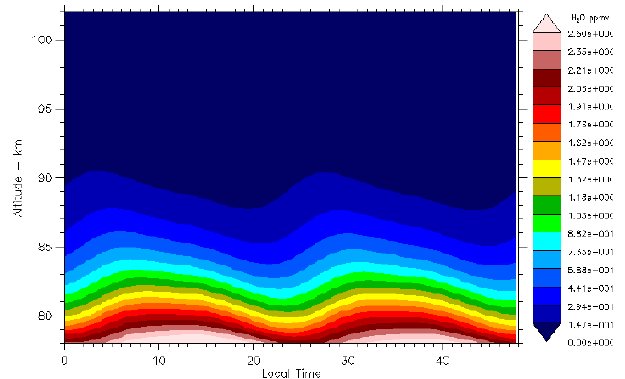
Fig. 1b. H 2 O profiles for model days seven through eight for August equatorial conditions. Note the scale is 1.32 times larger than in Fig. 1a. The August 90km H 2 O mixing ratio is approximately five times larger than for